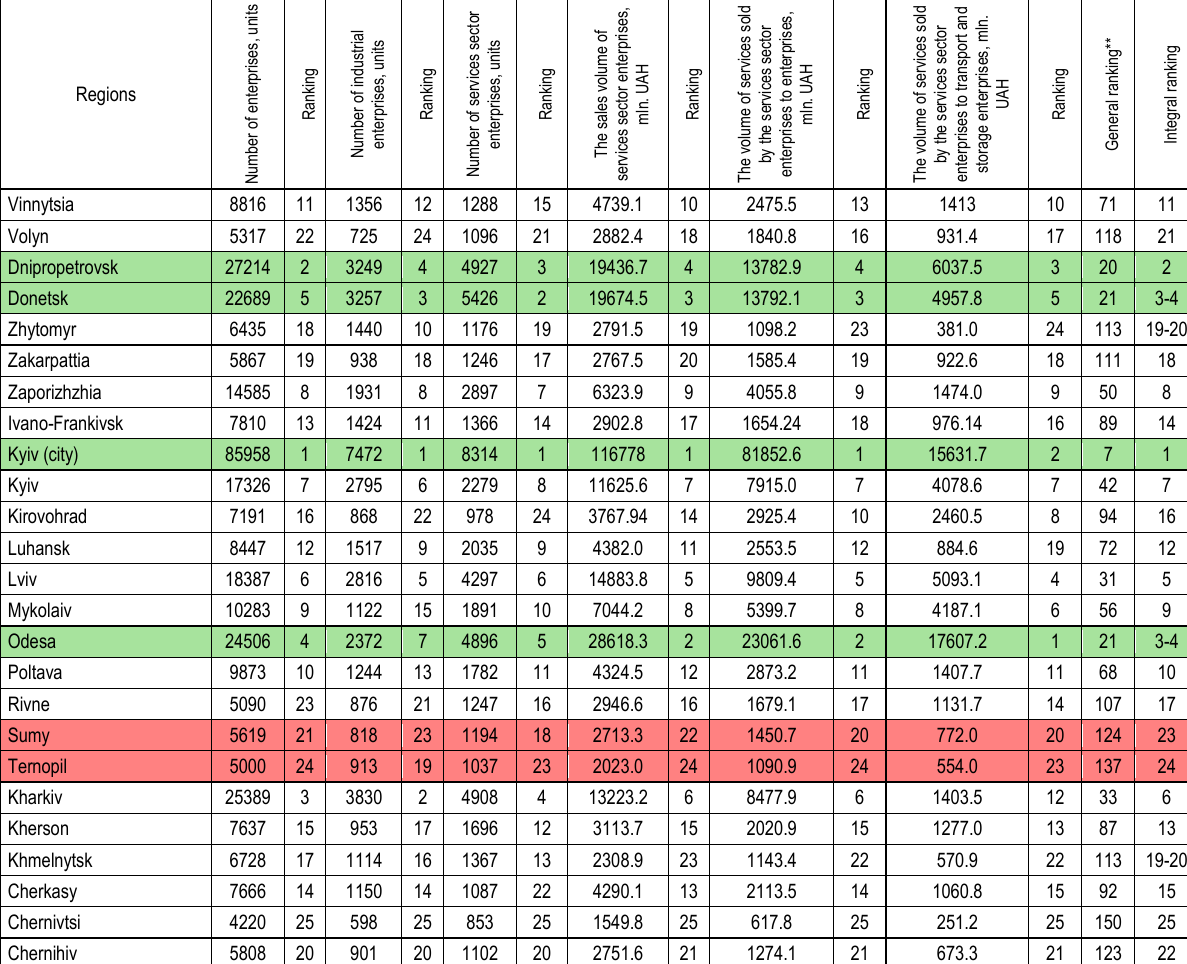
* - the lines marked in green show the best integral values of the region's indicators; and the lines marked in red show the regions with worst indicators ’ values; ** - calculated as the sum of ratings for each